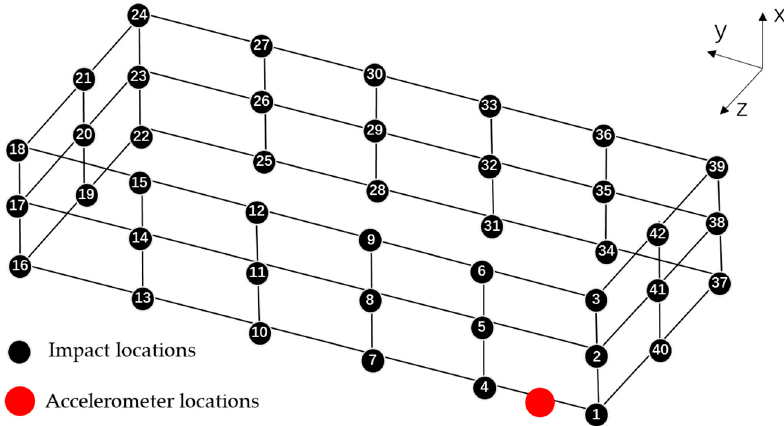
Figure 4. The point layout for impulse excitation tests.